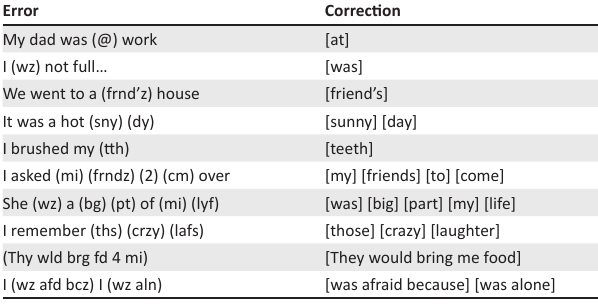
TABLE 2: WhatsApp language error committed by respondents in this study.